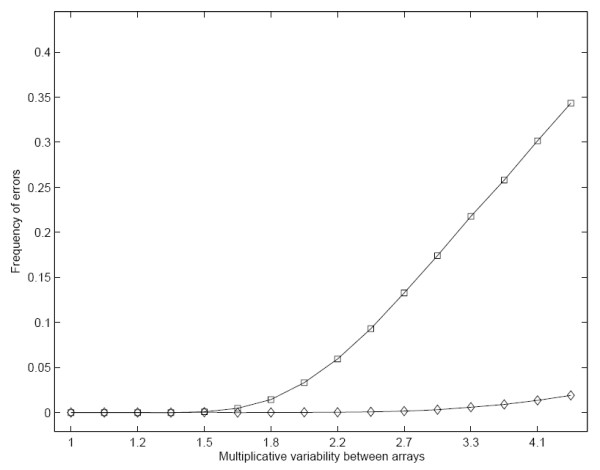
Average frequency of errors vs. multiplicative variability computed on synthetic data. This plot shows on the X axis the multiplicative variability between the arrays, and on the Y axis the average value of the frequency of genotyping errors. Symbols indicate the methods: squares refer to the direct Two-Array Method; diamonds refer to TAMGeS. For multiplicative variability greater than 1.8, the genotyping performance of TAMGeS results significantly better than that of direct Two-Array Method.